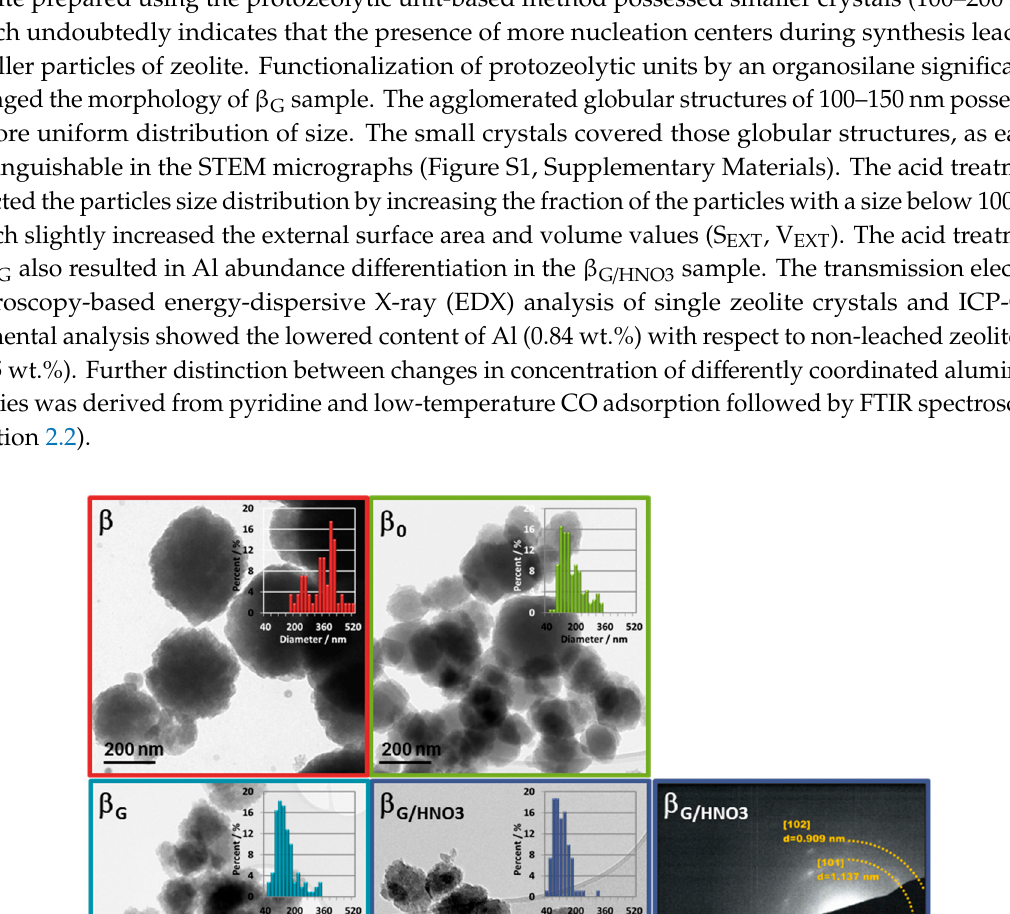
Figure 2. TEM micrographs of all studied samples and diffraction pattern of β G/HNO3 zeolite taken from the selected area.